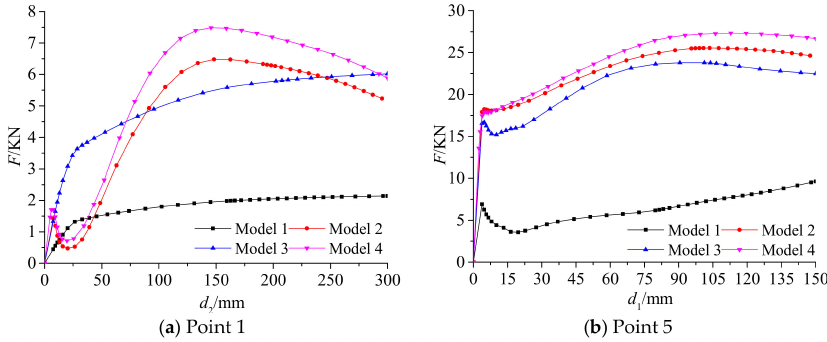
Figure 23. The displacement-load relationship of the four models.